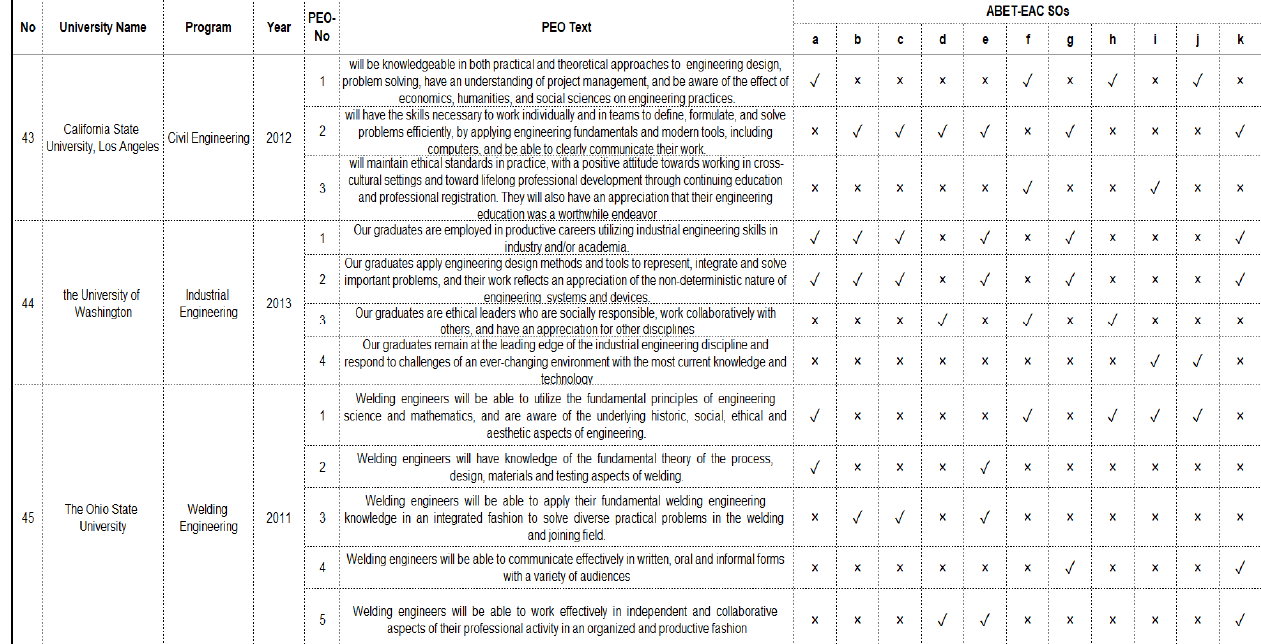
Figure 3. Snippet of the Raw PEOs-SOs data . Table 1. PEOs Label Set .